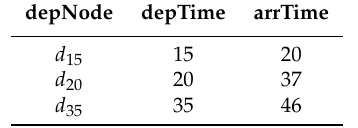
Table 1. An earliest arrival index example. I S departure nodes, in terms of valid departure and earliest arrival time, with departure stop S A , arrival stop S B , and traveling with bus or